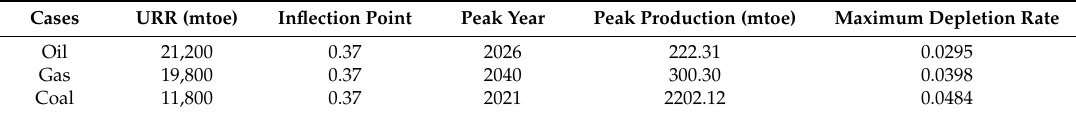
Figure 4. Forecasted results for Chinese conventional fossil fuel production by Wang et al. [33]. Table 5. Key factors applied to Chinese fossil fuel production forecasting.